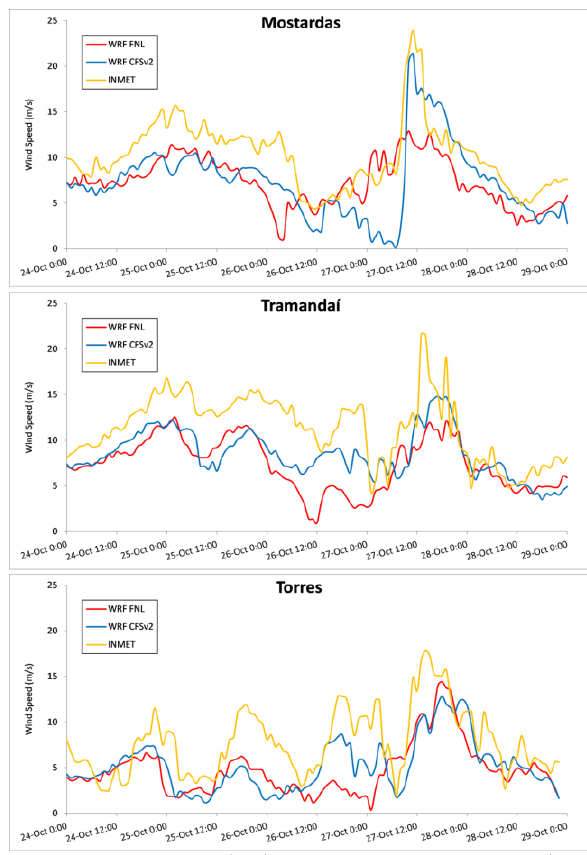
Figure 4. Wind speed (m/s) at 10 meters from WRF FNL (red line) and WRF CFSv2 (blue line) and wind gust speed (m/s) from INMET stations (yellow line), between October 24 and 28, 2018.